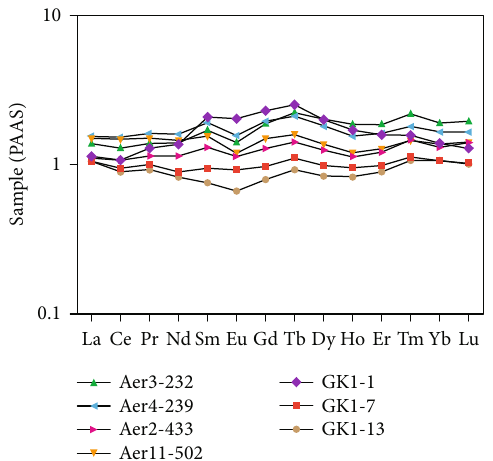
Figure 3: PAAS-normalized plots of rare earth elements in whole rock samples (PAAS from [46]).